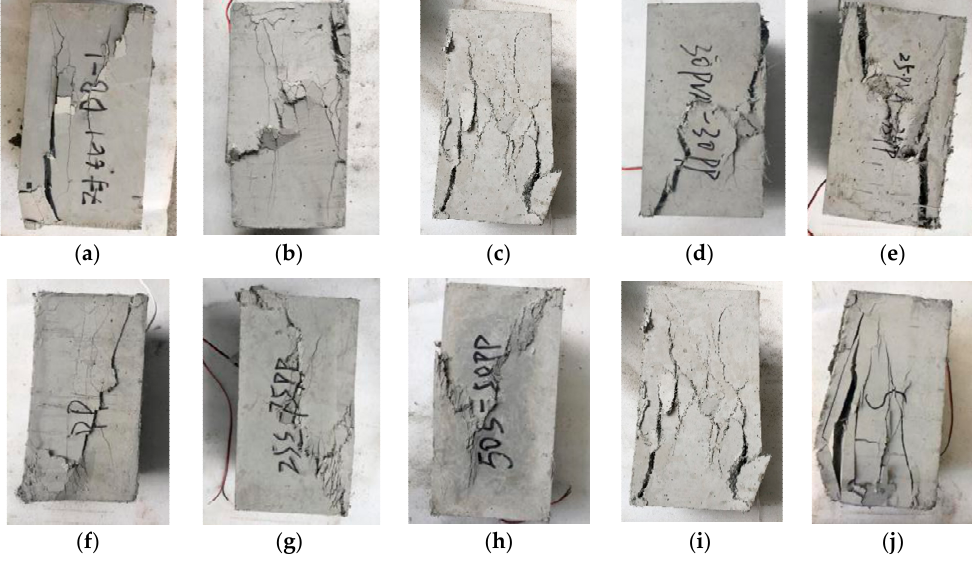
Figure 3. Failure mode of specimen. ( a ) DB; ( b ) PC1; ( c ) PC2; ( d ) PC3; ( e ) PC4; ( f ) PC5; ( g ) SC1; ( h ) SC2; ( i ) SC3; ( j ) SC4.